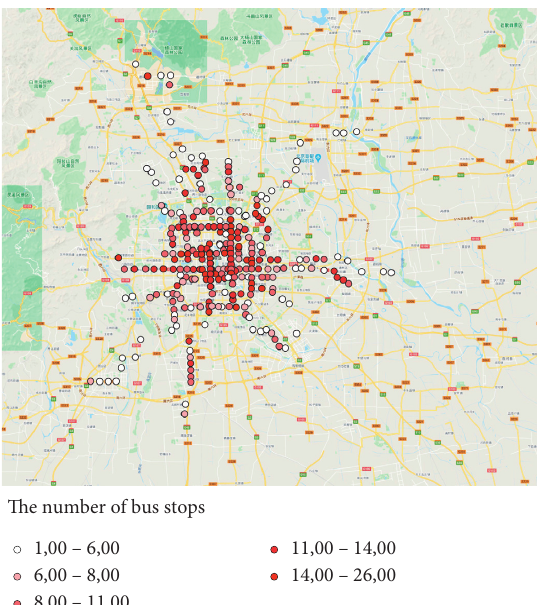
Figure 6: The metro network in Beijing, China, with the depth of color indicating the number of surrounding bus